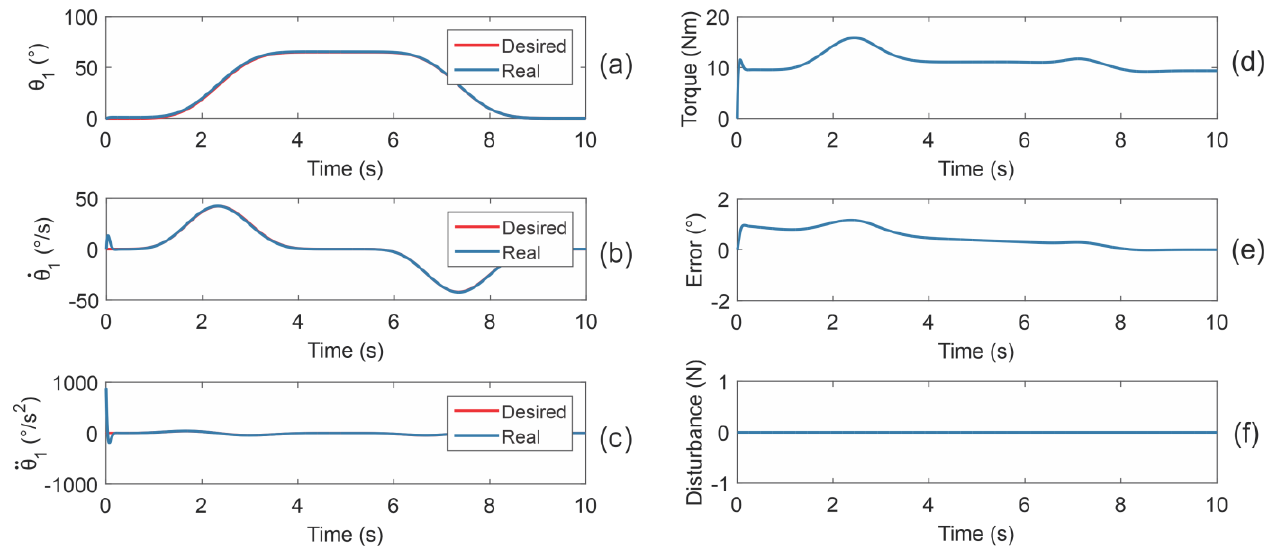
Figure 12. Reference trajectory tracking simulation without a disturbance input. ( a ), ( b ), and ( c ) are respectively the angular position, velocity, and acceleration of 𝜃 1 , ( d ) is the torque, ( e ) is the error, and ( f ) is the disturbance.